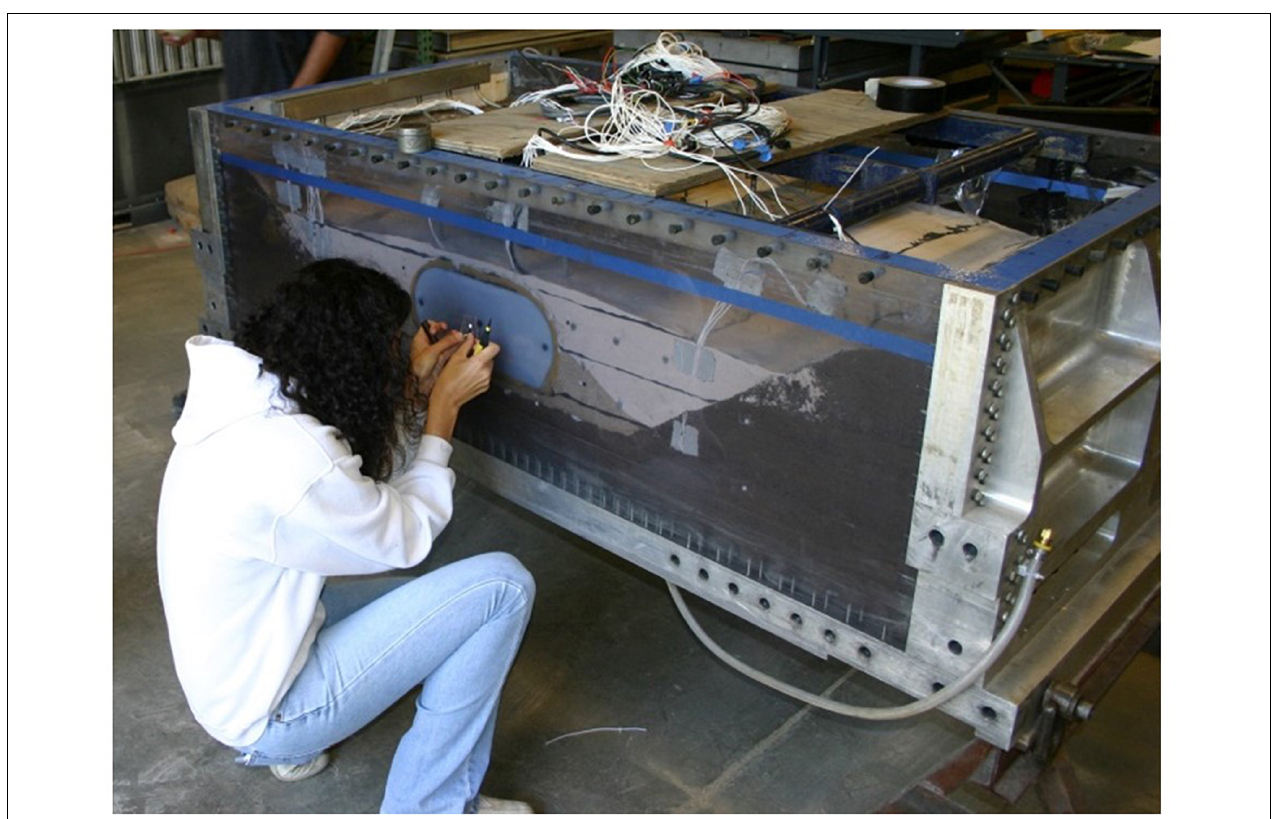
FIGURE 5 | Preparation of the BART Transbay tube model in the rigid glass-walled